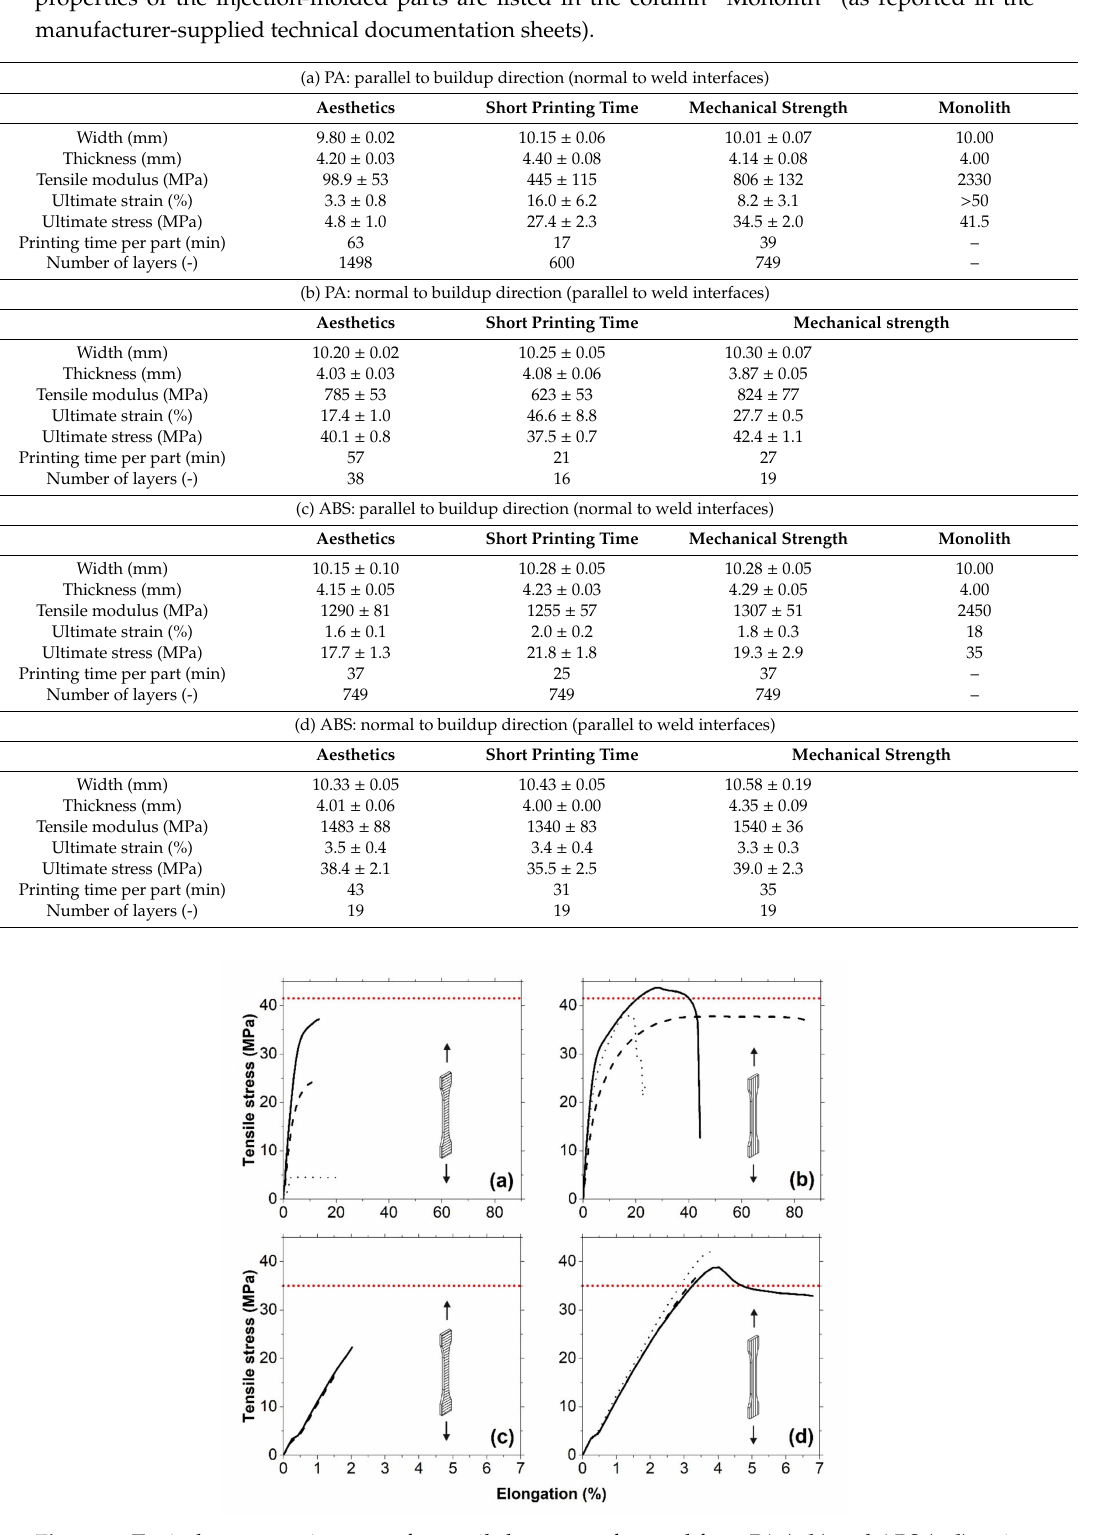
Figure 6. Typical stress–strain curves for tensile bars manufactured from PA ( a , b ) and ABS ( c , d ), using Table S2 in Supplementary Materials. The loading direction is normal ( a , c ) and parallel ( b , d )